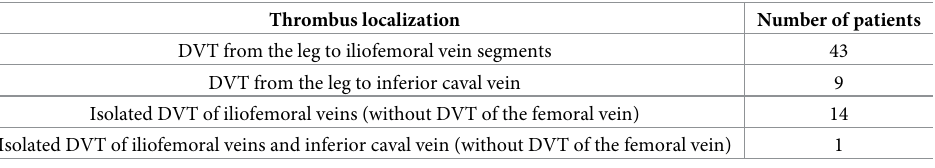
Table 1. Localization and prolongation of